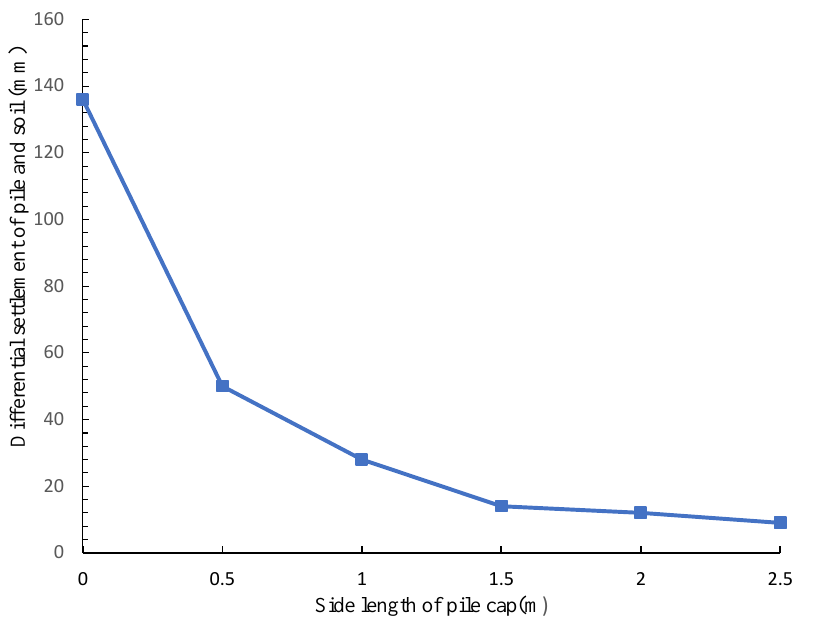
Figure 11. Effect of pile cap size on differential settlement of pile soil.